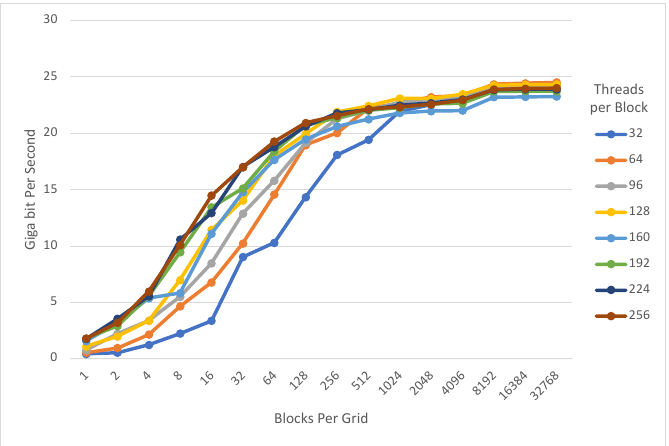
Figure 9. PRESENT-128 encryption: Comparison of the number of encryption per